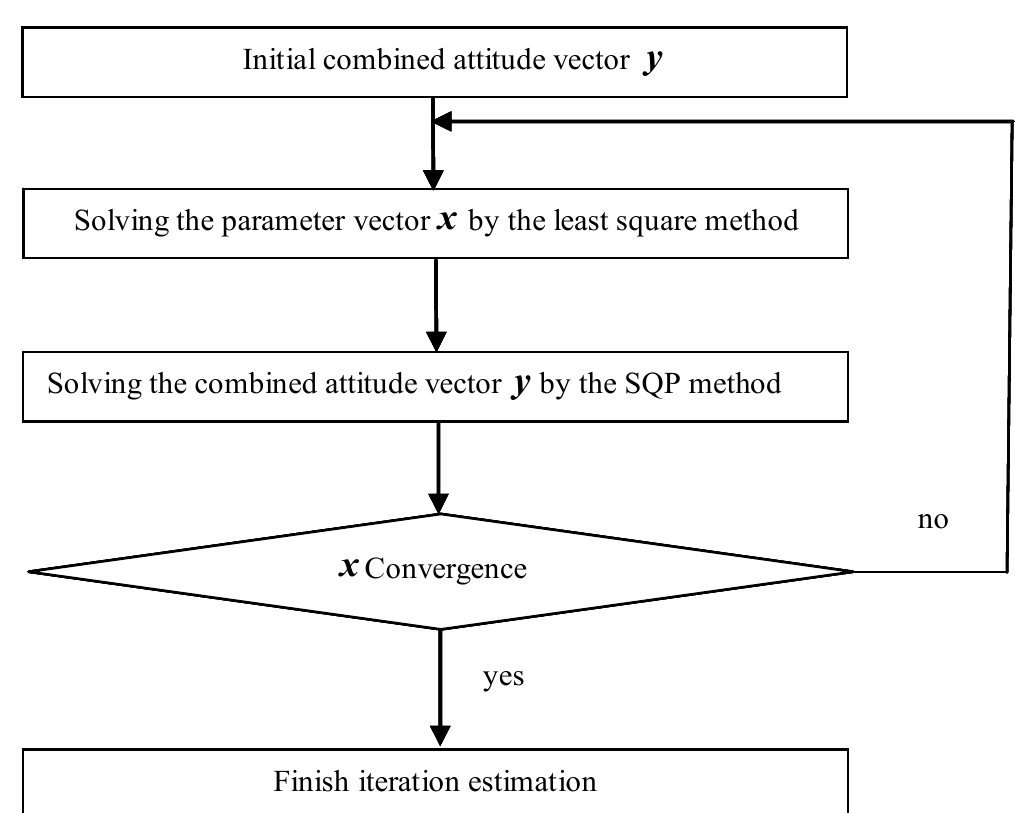
Figure 1. Flow of the two-step iterative